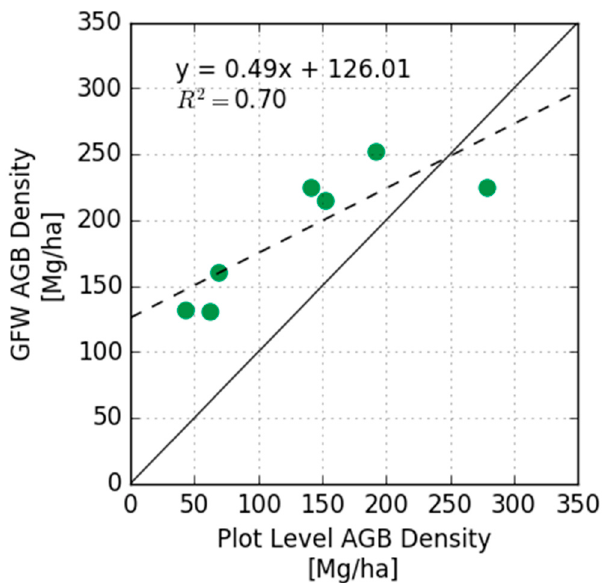
Figure 11. Plot-level AGB density ( x -axis) versus GFW-AGB density ( y -axis). 1:1 line shown in solid black. Linear fit shown in dashed black, with equation and r-squared reported.